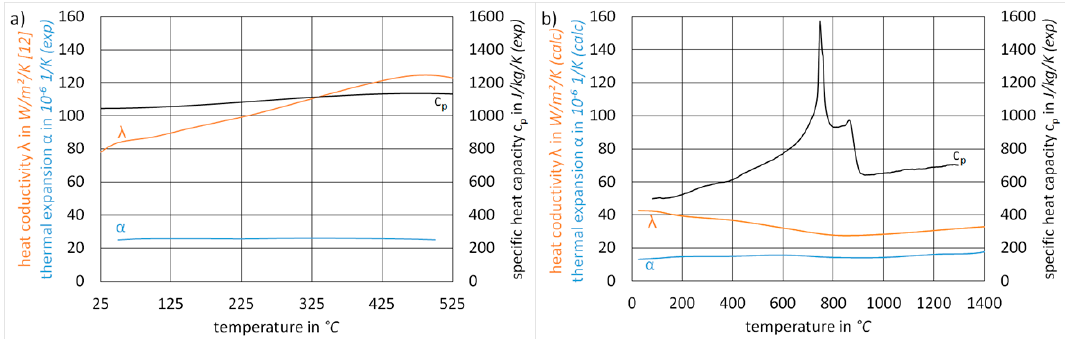
Figure 1. Thermo-physical properties of ( a ) magnesium AZ31 and ( b ) filler material G4Si1, taken partially from literature for magnesium [17], JMatPro for G4Si1 (calc), and partially from experiments (exp).